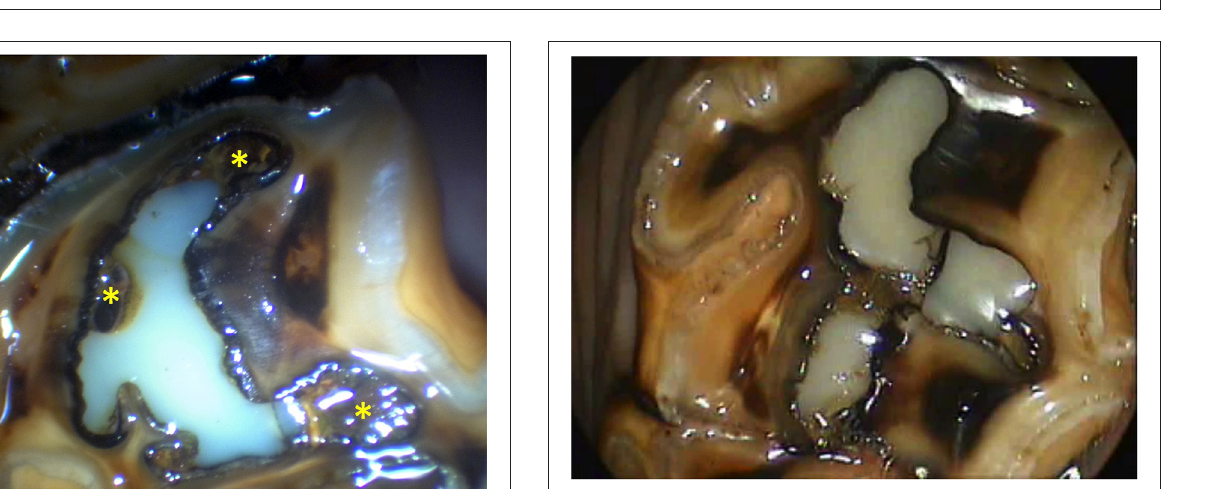
FIGURE 9 | Oroscopic images of a Triadan 209 immediately after (left) and 2 years 4 months after (right) infundibular restoration.